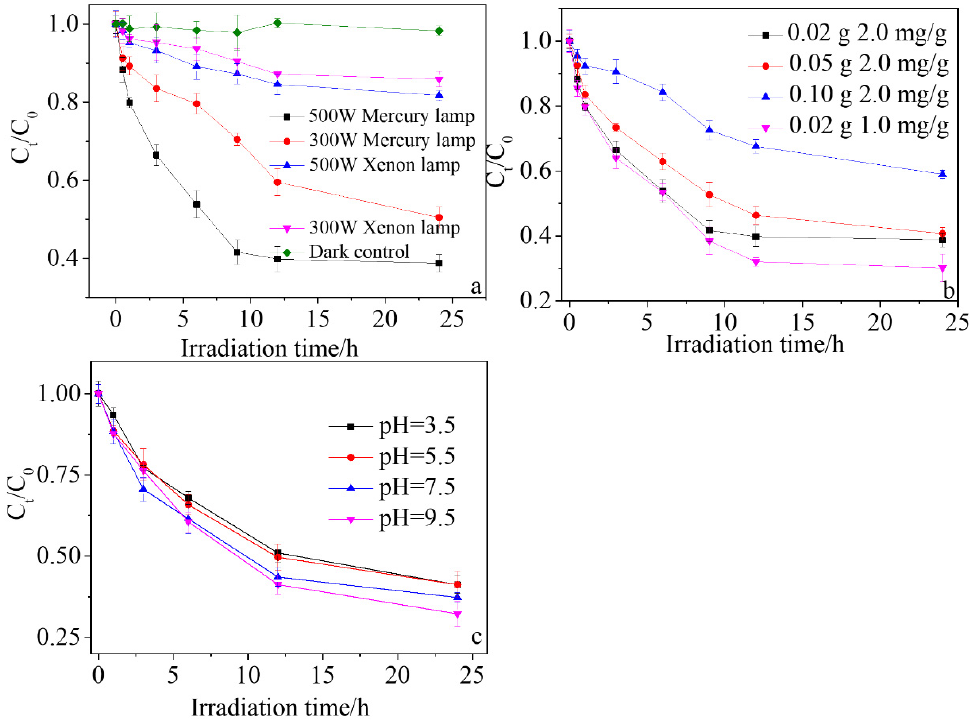
Figure 1. BDE-209 photodegradation in soil suspensions under: ( a ) different light sources; ( b ) dif- ferent initial concentrations; ( c ) different pH values. initial concentrations; ( c ) different pH Table 4. Photolysis kinetic parameters of BDE-209 in soil suspensions under different pH values.